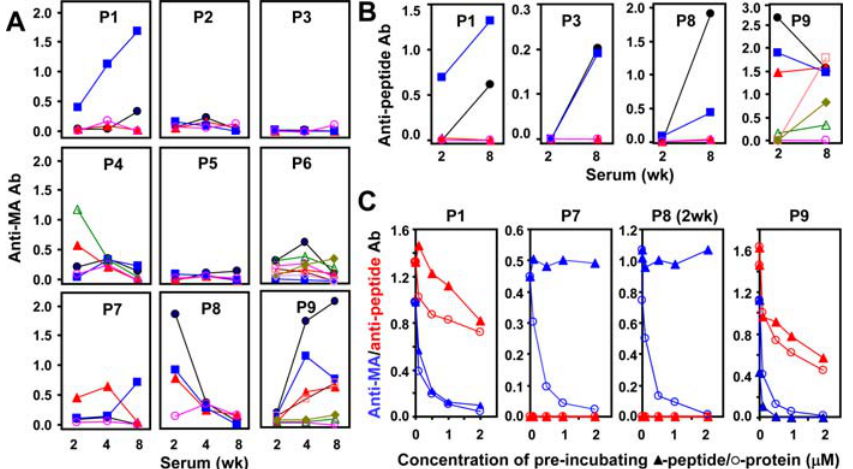
Figure 3. Temporal evolution of HRS peptide-induced antibody responses and characterization of relative peptide vs. protein binding affinity. Symbols denote data points corresponding to the mean OD 450 values of triplicate ELISA samples (after subtraction of no antigen and anti-MBP background) generated by sera obtained from individual peptide-immunized mice, and lines serve as a visual guide. Individual panels in A) depict levels of peptide-induced antibodies recognizing a HRS fusion protein (consisting of the amino terminal 151 amino acids of murine HRS linked to maltose binding protein=MA/MBP) at various time points after a single immunization with peptide/CFA emulsions. The plots in B) show corresponding anti-peptide antibody titers induced by immunization with the indicated peptides (line colors identify matched serum samples). Error bars are negligible and have therefore been omitted. Finally, panel C) demonstrates competition assays in which serum obtained from HRS peptide- immunized mice (8 weeks following immunization unless otherwise indicated) is pre-incubated with different molar concentrations of immunizing peptide (closed triangles) or MA/MBP (open circles) before being subjected to ELISA. Substrate antigens consist of the immunizing peptide (red lines and symbols) or MA/MBP (blue lines and symbols). Molar concentrations of peptide and protein used for pre-incubation are equivalent at individual points along the x-axis. OD 450 values again represent the mean of triplicate samples; negligible error bars are not shown.